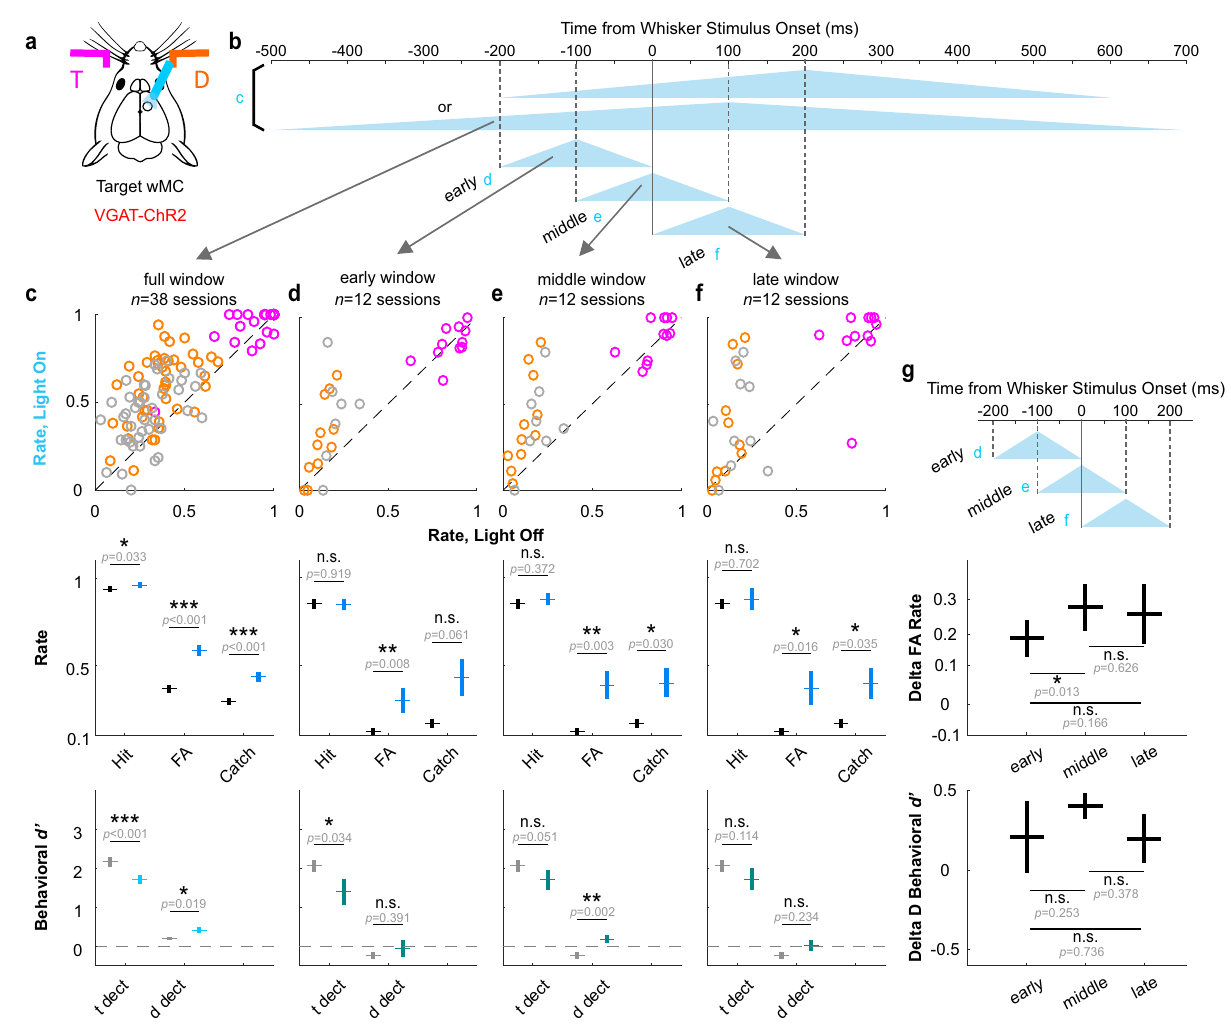
Fig. 6 | Effects of suppressing target-aligned wMC in transient, varying time windows. a Illustration of suppressing target-aligned wMC in VGAT-ChR2 trans- genic mice. b Illustration of differentpro fi les of optogenetic light. “ c ” indicatesthe light pro fi les used the previously described experiments. “ d ” , “ e ” , and “ f ” indicate the light pro fi les used for transient varying time wMC suppression. c Behavioral results of light pro fi le “ c ” , as same as Fig. 1g left row, and included here for refer- ence. d – f Behavioral results corresponding to light pro fi les “ d ” , “ e ” , “ f ” ,